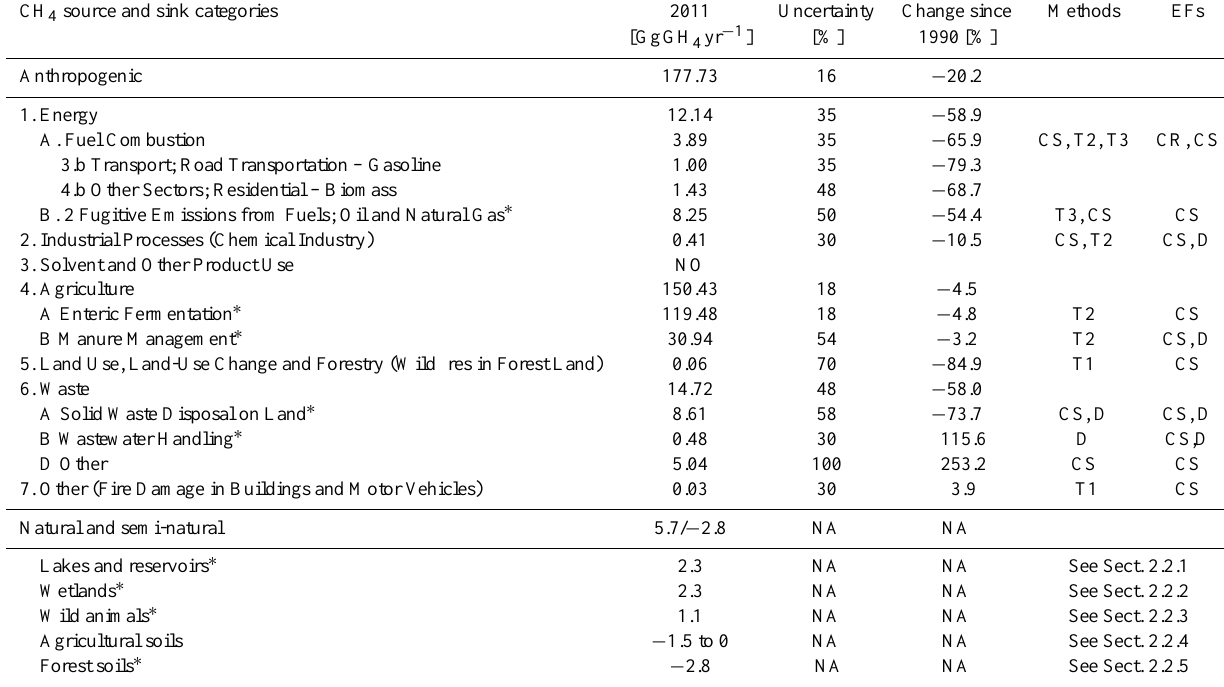
Table 2. Swiss CH 4 emissions in 2011, uncertainty estimate, and changes from 1990 to 2011 for the major source categories listed by the official Nomenclature for Reporting (NFR) codes. The provided uncertainty estimates follow the Tier 1 methodology (IPCC, 2000), represent half of the 95% confidence interval expressed in percent (IPCC, 1997), and account for uncertainties in emission factors (EFs) and activity data for the individual level or category. Total national emissions exclude the Land Use, Land-Use Change and Forestry sector (LULUCF in italics) as well as International Bunkers (not shown), in accordance with the reporting requirements under the UNFCCC. Methods applied and EFs used are indicated (D = IPCC Default, T1 = IPCC Tier 1, T2 = IPCC Tier 2, T3 = IPCC Tier 3, CR = CORINAIR, CS = country- specific). All data for the anthropogenic sources are taken from the national Greenhouse Gas Inventory (FOEN, 2013), while CH 4 fluxes from the natural categories are based on estimates presented in this study. The categories indicated with an asterisk are included in our spatially explicit